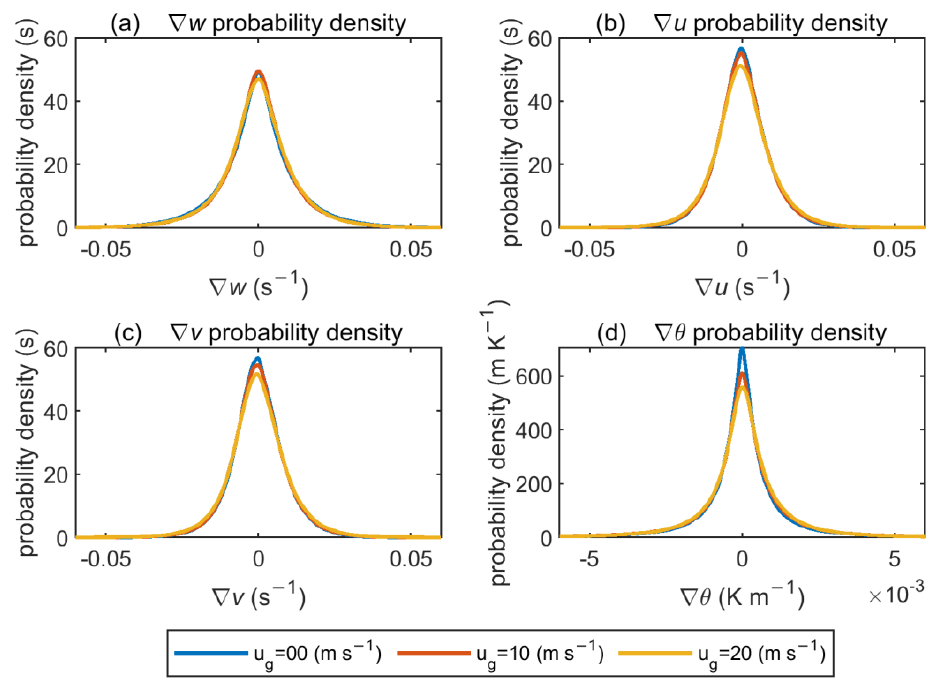
Figure 4. Comparison of w ( a ), u ( b ), v ( c ), and θ ( d ) spatial horizontal gradient PDFs from LES simulations for z / z i = 0.5 at 3 h of physical time across the range of U g . Blue line U g = 0 ms −1 ; Red line U g = 10 ms −1 ; Yellow line U g = 20 ms −1 . The x-coordinate in the plots represent w ( a ), u ( b ), v ( c ), and θ ( d ) gradient vector values. The y-coordinate represents the probability density.